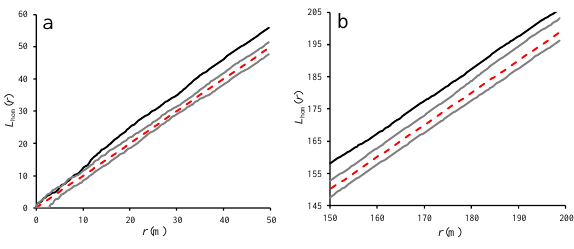
Figure 8. Homogeneous L -function at scales of 0-50 m (a) and 150-200 m (b) for heterogeneous pattern of wild pistachio trees. The results of inhomogeneous g -function were approximately in accordance with the results from previous inhomogeneous functions ( K - and L -functions). For the pattern shown in Fig. 4, inhomogeneous g -function indicated aggregation at scales of 5-21 m , and random distribution at all other scales (Fig. 9a). However, this function revealed the regular distribution of tree at scales of 150-162 m , and randomness at all other scales (Fig. 9b).